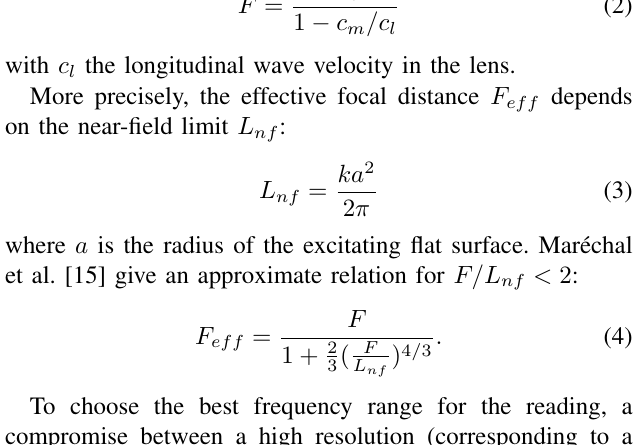
Fig. 3. High temperature ultrasonic transducer: TUSHT ® (cid:11) 40 mm with straight (left) and 90° (right) electrical wire